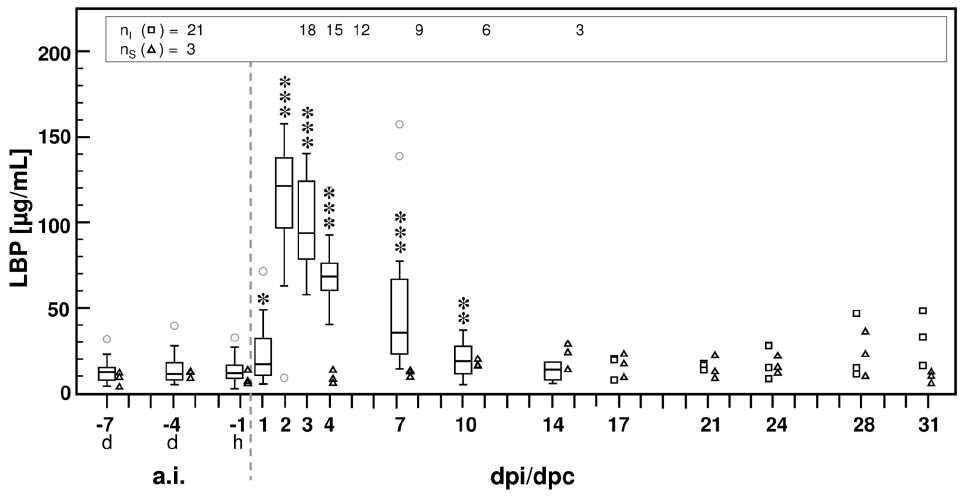
Figure 3. Concentration of lipopolysachharide binding protein (LBP) in peripheral blood before and after C.psittaci challenge. After inoculation of C. psittaci , LBP concentration was significantly increased until 10 dpi. Based on the group size of calves inoculated with 10 8 ifu/animal (n I ) data are given as Box and Whisker plots or as individual data (squares, if n # 3), respectively. The LBP concentrations obtained in sentinels (n S, triangles) increased slightly after 7 days post contact (dpc) but did not exceed 35.1 m g/mL (i.e. maximal LBP concentration: at 28 dpc). Due to small sample size no statistical hypothesis was applied to this group. For statistical analysis of experimentally challenged calves, baseline data (averaged per animal) were compared to data obtained at different time points after challenge (Wilcoxon signed-rank test). Values of * P # 0.05, ** P # 0.01, and *** P # 0.001 were considered significant. Outlier values are indicated by small grey circles. a.i ante infectionem . d day. dpi days post inoculation. dpc days post contact to inoculated calves. h